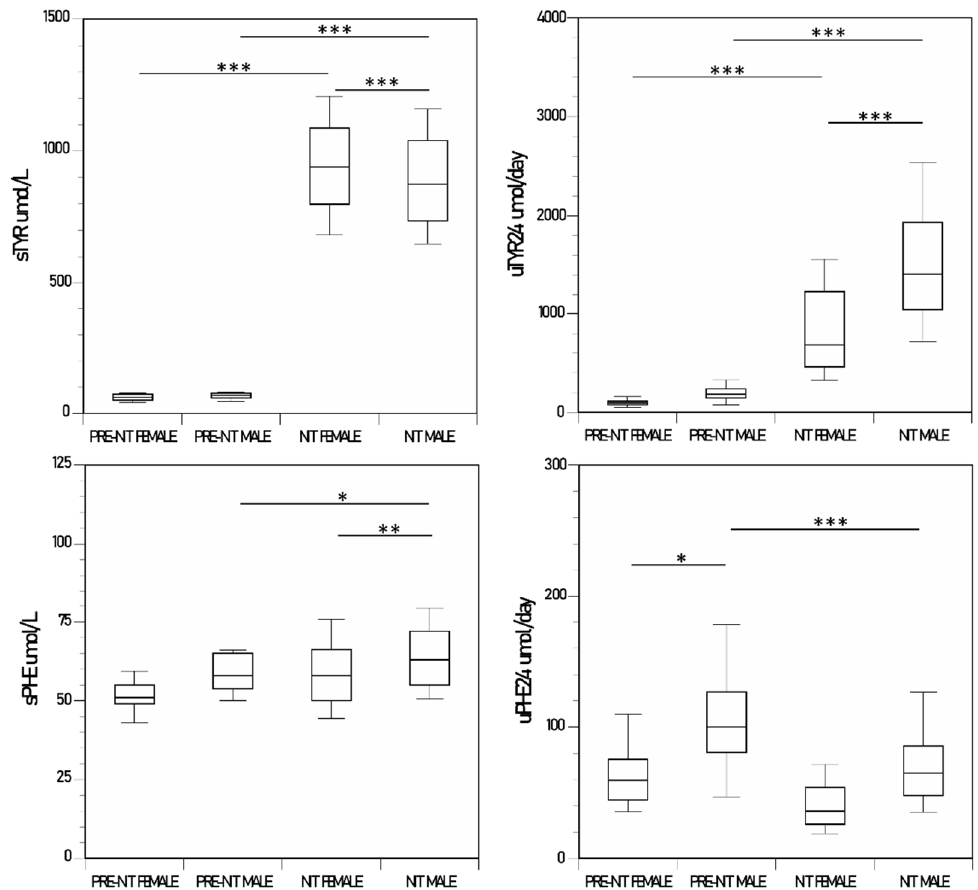
Figure 3. Changes in sTYR and uTYR 24 and sPHE and uPHE 24 , in the nitisinone group of the SONIA 2. ( p -values indicated for comparison between female pre-nitisinone (n = 24), male pre-nitisinone (n = 45), female nitisinone (n = 120), male pre-nitisinone (n = 225), sampling points where statistical significance was achieved) (data shown as boxplots with median) (statistical significance p expressed * < 0.05, ** < 0.01 and *** < 0.001, respectively).